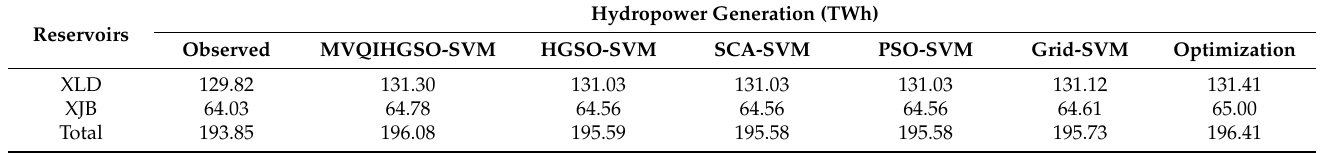
Table 9. Total hydropower generation based on observed and predicted data as well as optimal